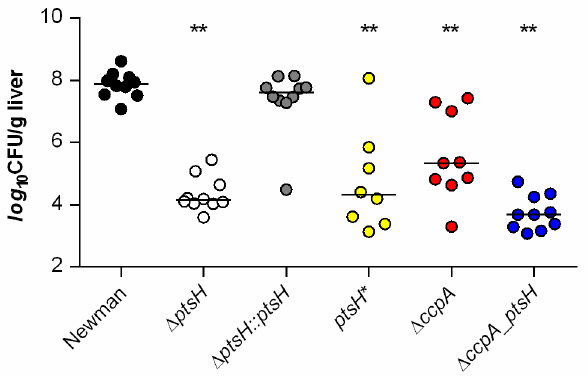
Figure 7. Inactivation of ptsH and/or ccpA results in decreased bacterial burden of S. aureus Newman in a murine abscess model. C57BL/6N mice were infected retro bulbar with 5 × 10 7 CFU of S. aureus strains Newman (black symbols), its ∆ ptsH (white symbols) and ∆ ccpA (red symbols) mutants, the ptsH * mutant (yellow symbols), the ∆ c cpA_ptsH double mutant (blue symbols), and the cis-complemented ptsH derivative (grey symbols), respectively. Bacterial loads in liver tissue homogenates were determined four days post infection. The data display the median (horizontal lines) and individual values of every animal (dots; n = 8–10 animals per group). **, p < 0.01 (one-way ANOVA and Holm-Sidak’s multiple comparison test; only differences between Newman and mutants are shown).